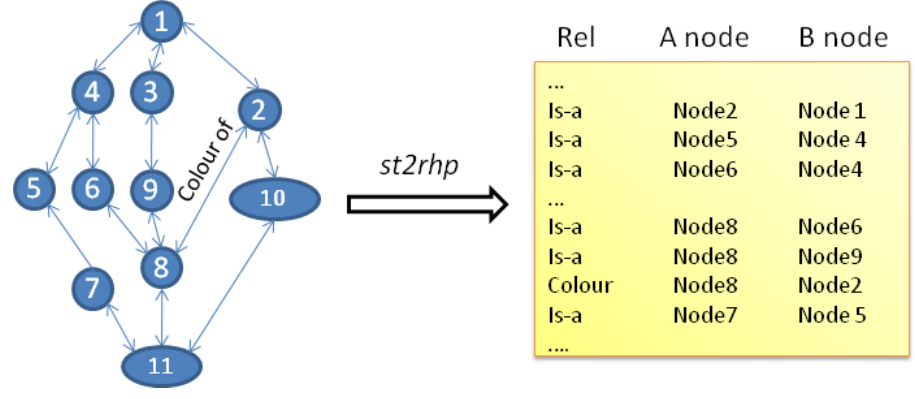
( left ) to the tabular structure used by the RHP ( right ).